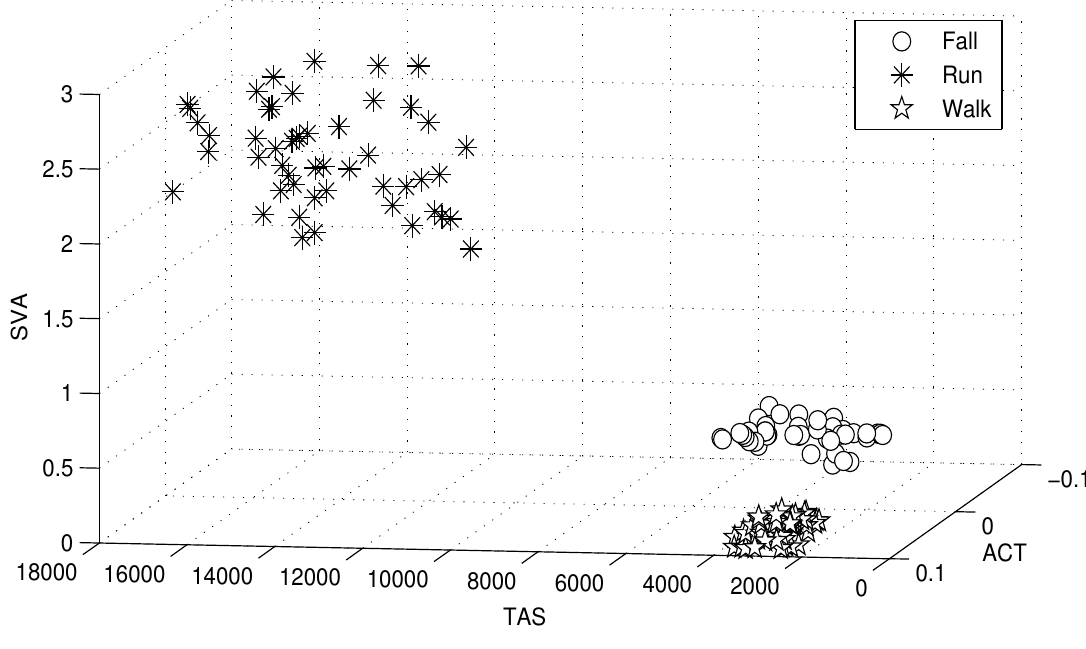
Figure 3. 3D feature space with three human motions